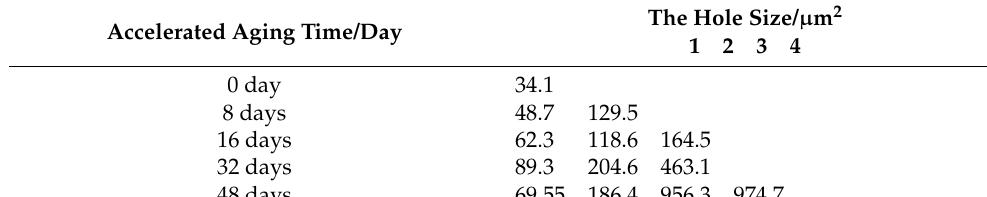
Table 1. Statistical results of hole area.